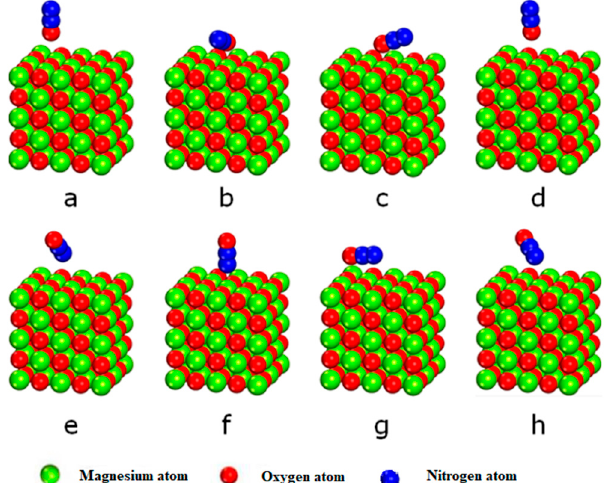
Figure 2. Surface model and state density analysis of MgO (100).